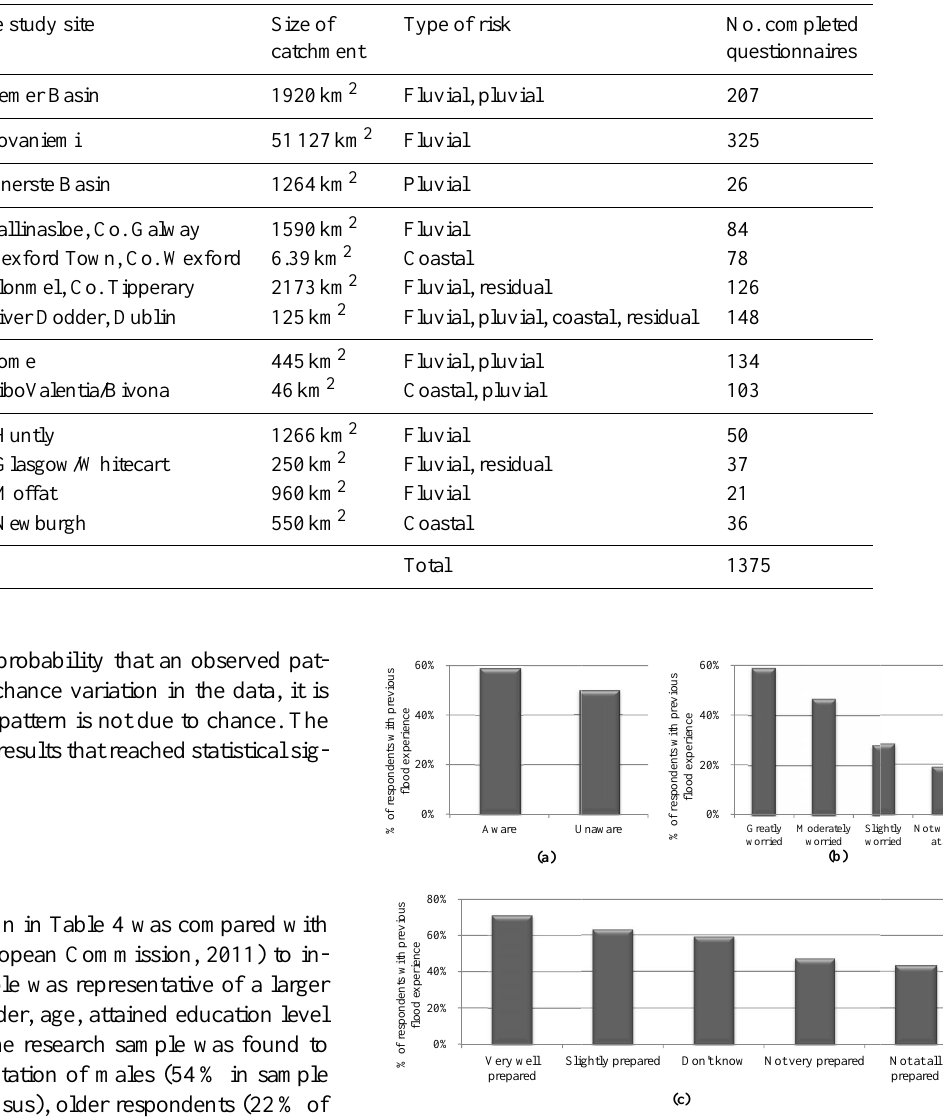
Table 1. Characteristics of case studies undertaken.